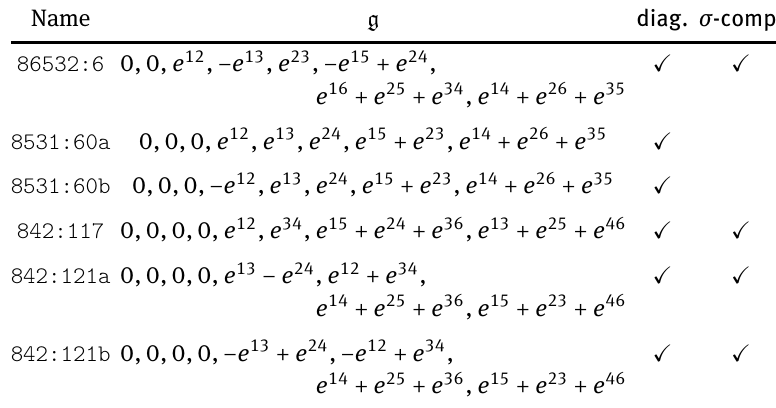
Table 1: 8-dimensional nice Lie algebras with a non-Ricci-flat, Einstein metric of diagonal or σ -diagonal type Name g diag. σ